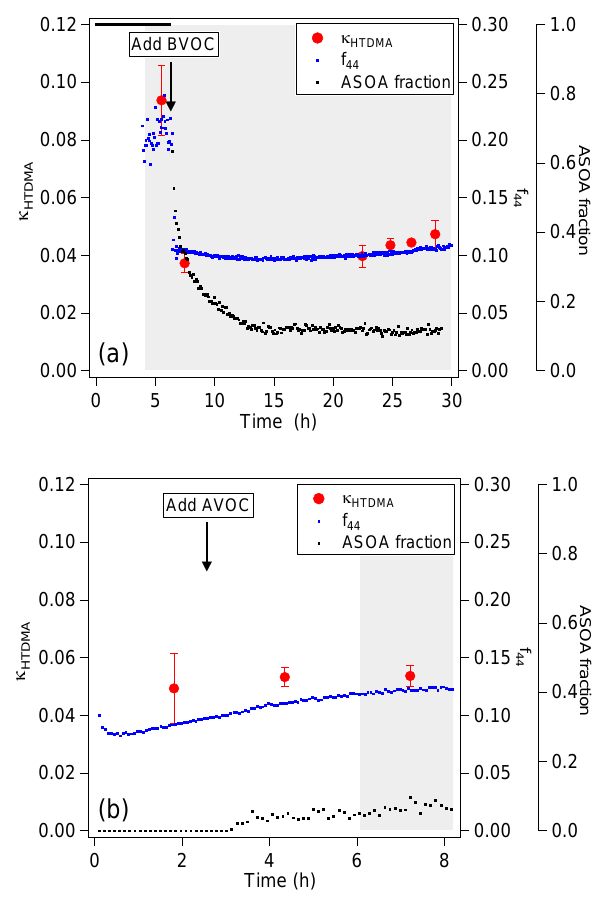
Figure 5. κ HTDMA of ABSOA from experiments when AVOC and BVOC were added sequentially (same experiments as in Fig. 2). (a) Toluene was added first and the monoterpenes were added 6h after- wards as indicated by the vertical arrow. The shaded areas indicate the dark periods. κ HTDMA decreased significantly with the decrease of ASOA fraction due to the addition of BVOC. At the same time, f 44 decreased distinctively. (b) Monoterpenes were added first and toluene was added 2.6h afterwards as indicated by the vertical ar- row. κ HTDMA increased slightly as only a minor fraction (<10%) of ASOA was formed. At the same time, f 44 also increased slightly.